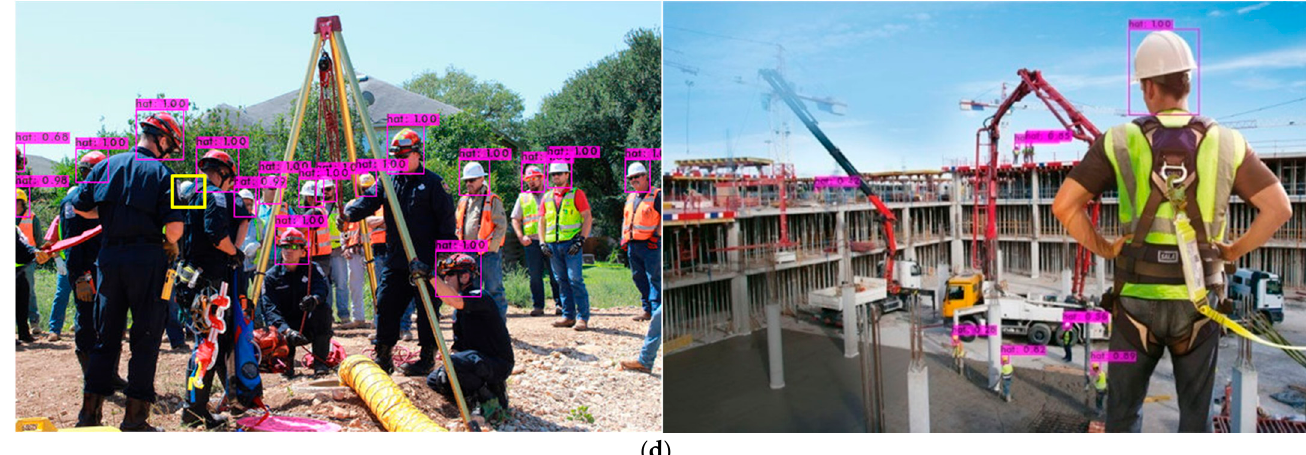
Figure 8. Comparison of detection results of different algorithms. ( a ) The detection result of the YOLOv3 model; ( b ) the detection result of the YOLOv4 model; ( c ) The detection result of the YOLOv5 model; ( d ) the detection result of theRSSE-YOLOv3 model. The object marked by the yellow box in the figure represents the missed detection target.